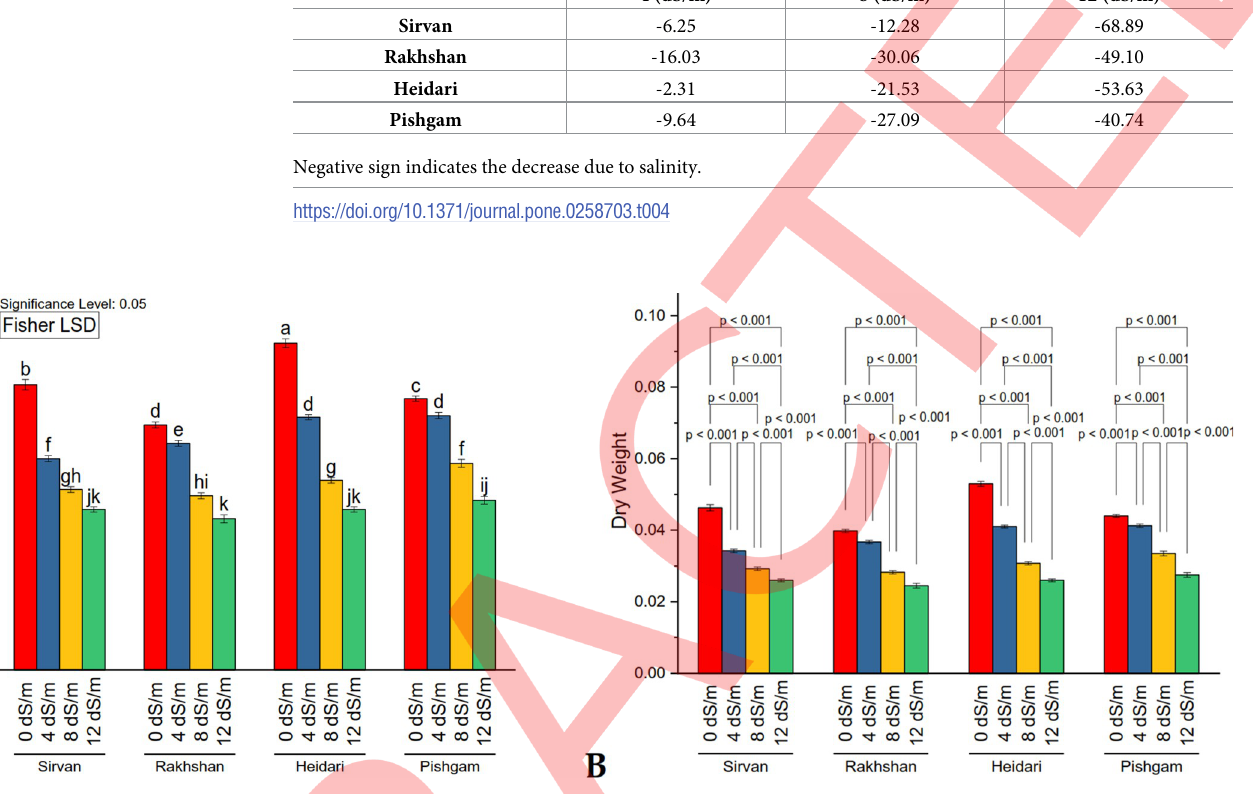
Fig 5. Effects of salinity on dry weight in wheat varieties. A) Means are average of four replicates. Different values showed significant difference at p < 0.05 compared by LSD. B) Different values at bars are p values obtained during LSD comparison of wheat varieties and salinity levels.